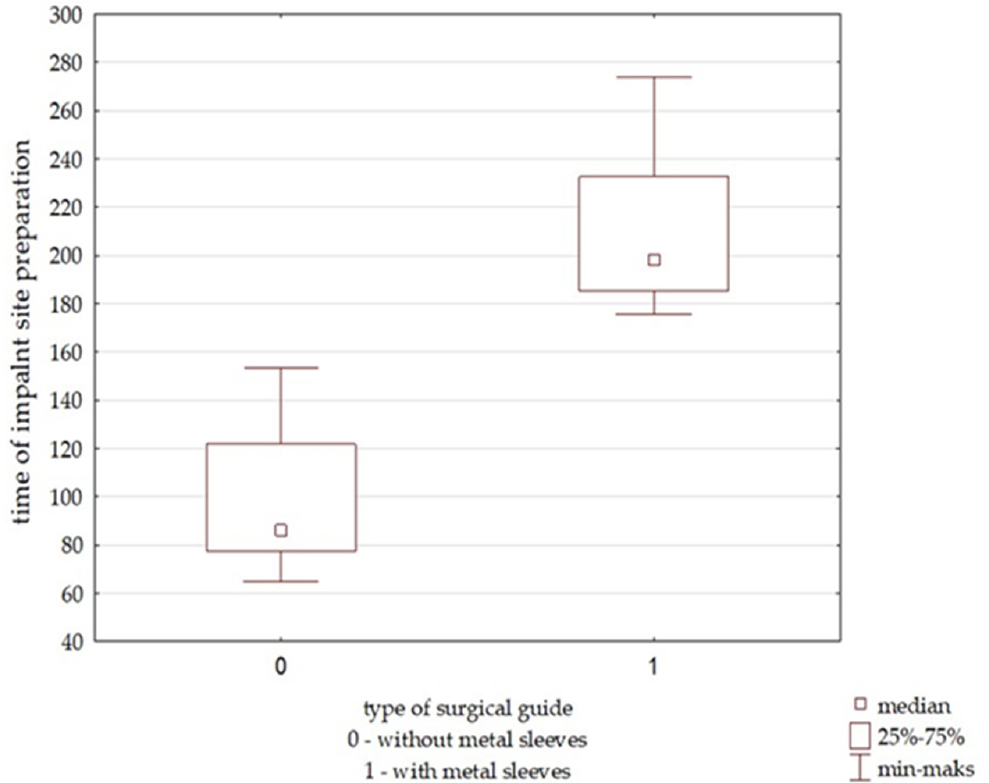
3 Table 1. Results of basic statistical analysis.